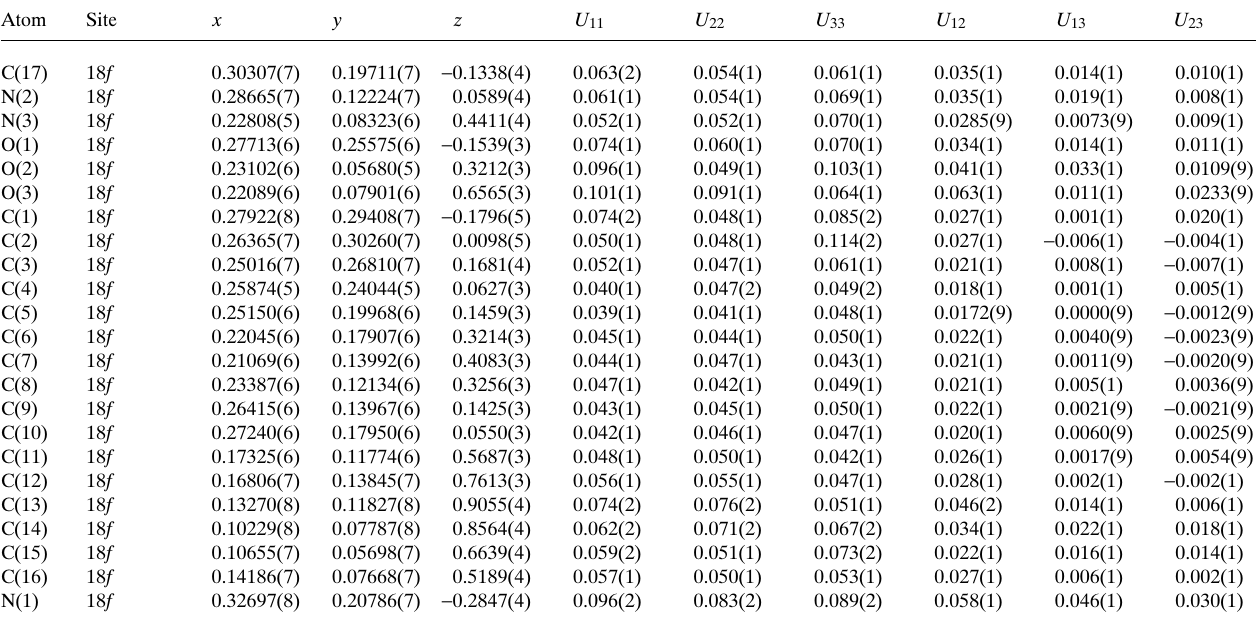
Table 3. Atomic coordinates and displacement parameters (in Å 2 ) .